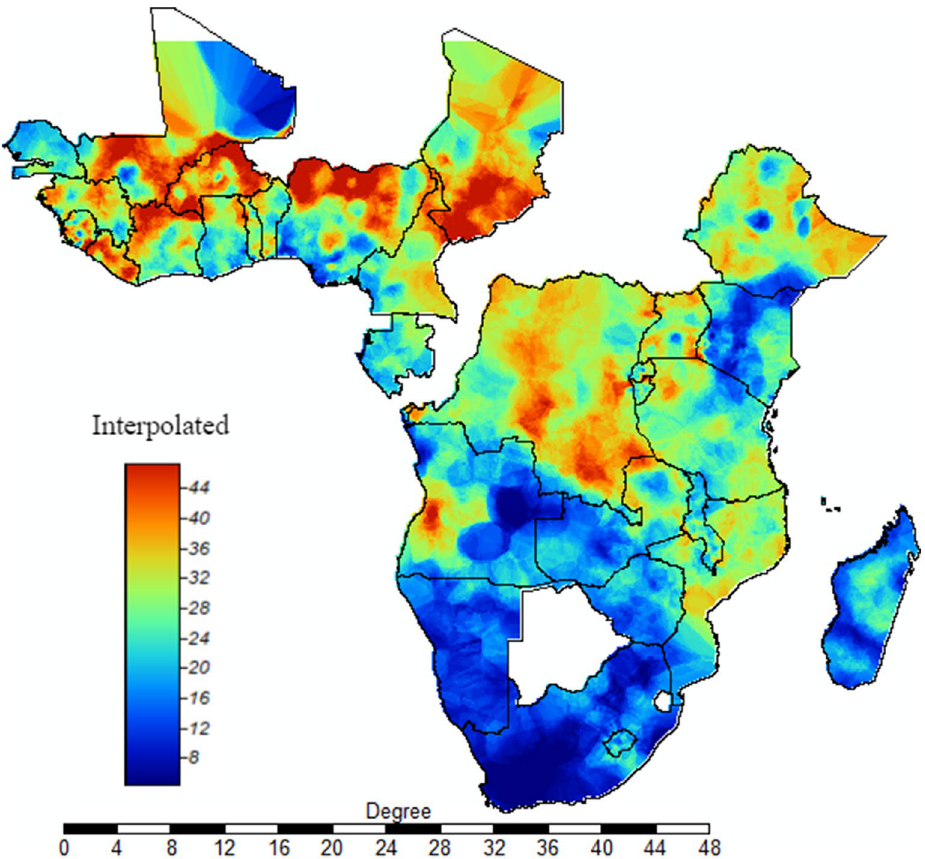
Figure 7. Interpolation of mothers who suffer at least one child death: the interpolated continuous images provided by the interpolation ordinary kriging. The colour through bold blue to bold red indicates an increase in the prevalence of mothers who suffer from child death. This analysis was carried out at SAGA